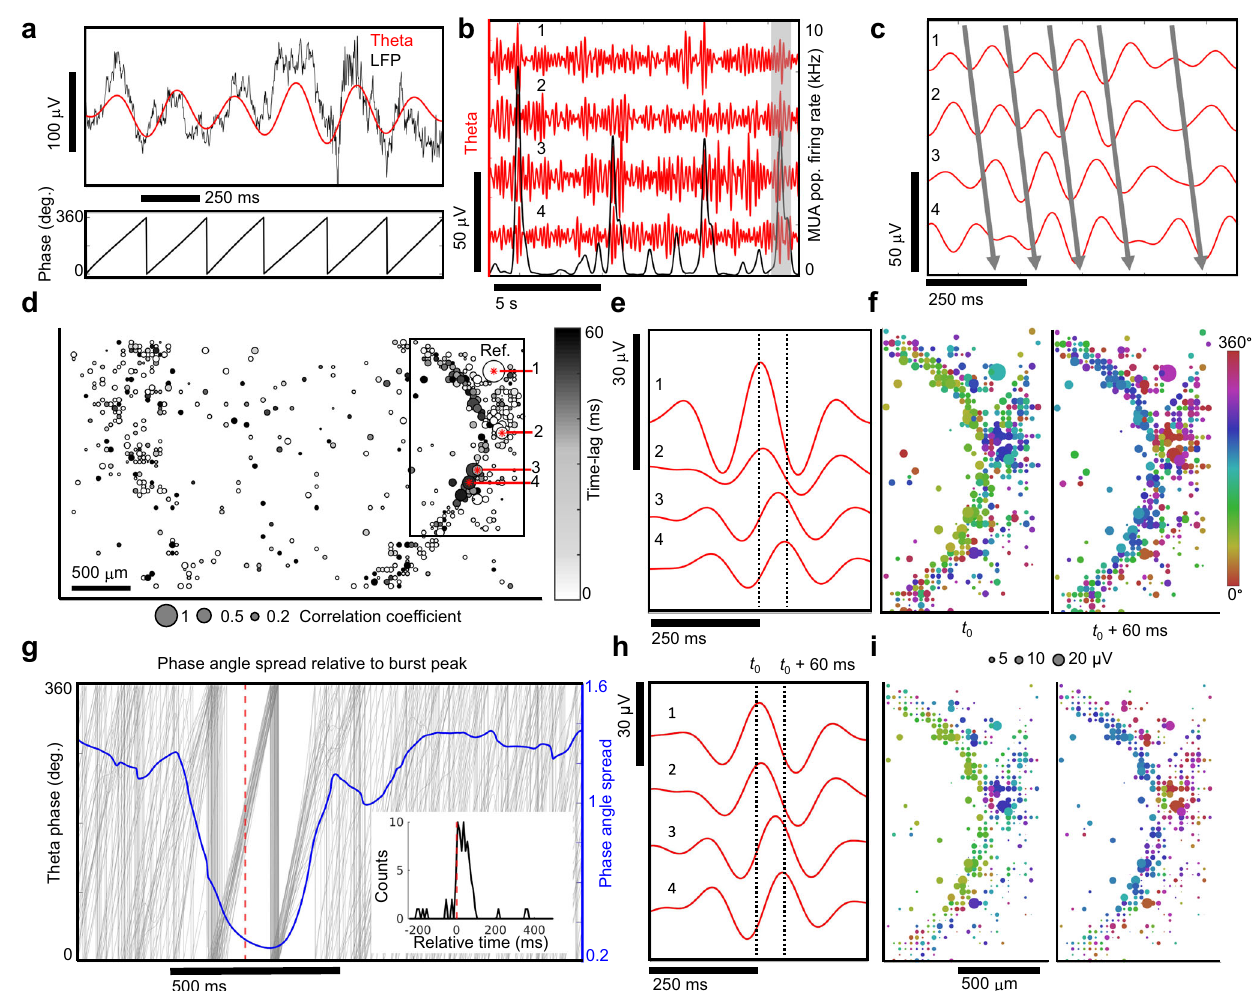
Fig. 7 | Spatial and temporal coherence of theta oscillations with neuronal population bursts. a The raw local fi eld potential (<500Hz, black line) and the 4 – 8Hz theta fi ltered band (red) (top). The phase of the theta oscillation (bottom). b Theta band oscillations (red) from four different recording sites and the multi- unitactivity (MUA) population averaged fi ring rate (black) averaged over a 100ms window. c Zoomed in view of highlighted black rectangle in b . The solid lines indicate the relative phase offsets of theta oscillations across spatial sites of the organoid.Withinanarrowtimewindowtheseoscillationsshowedconsistentphase offsets. d Spatial correlation map of theta oscillations. The correlation coef fi cient (bubble size) is shown with respect to the seed reference site (1) and the relative phase-lagwithrespecttothereferenceelectrodeshowningrayscalerevealsspatial alignment of theta oscillations. e Signal averaged theta oscillations using peaks fromelectrode(1)asareference.Thenumbers1 – 4in c – e , h allrefertothesameset